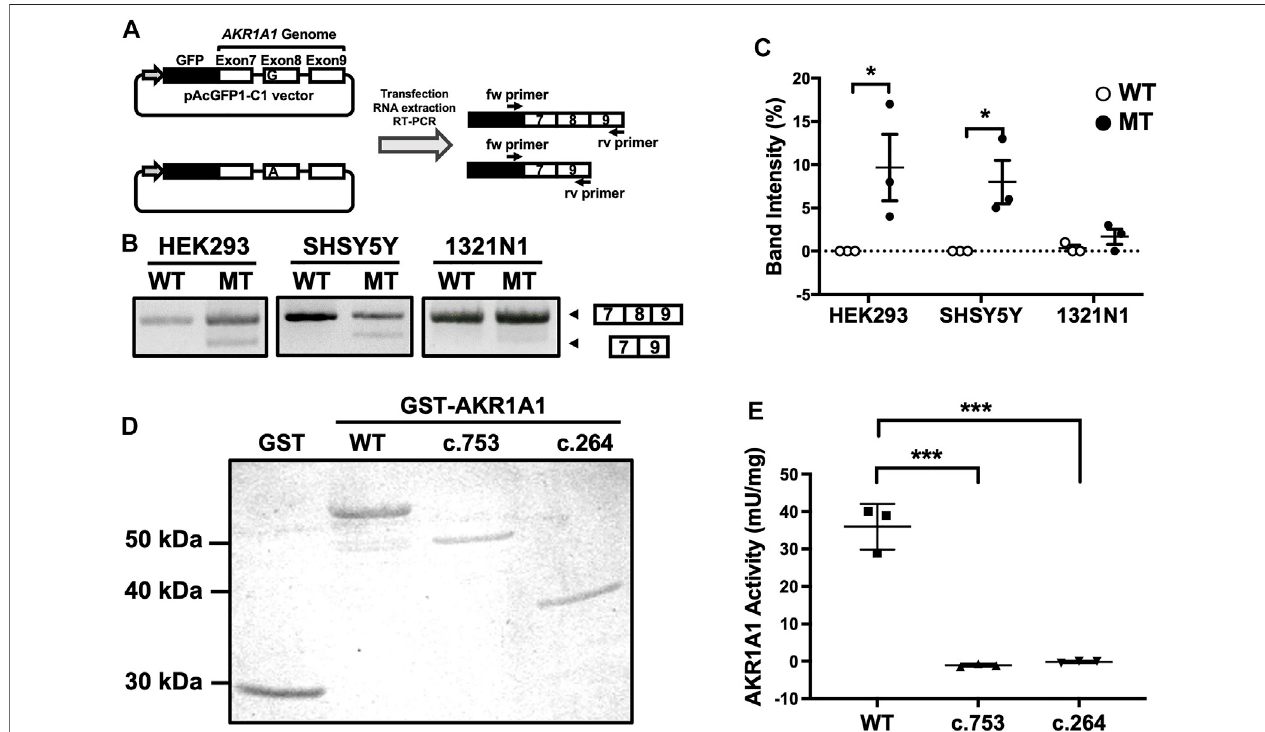
FIGURE2| Exonskippinginducedbythec.753G > Avariantin AKR1A1 . (A) Anoutlineofthesplicingassayisshown.Exon8skippingwascon fi rmedusingcDNA generatedfromHEK293,SH-SY5Y,and1321N1 cellsexpressingminigenesforWTorc.753G > Avariant(mutant[MT]). (B) Theresultsofthesplicingassayareshown. The upperband indicates products including exons7 – 9,whereas thelowerbandshows exon8skipping products, including only exons7and9. (C) Datarepresentthe meanofthreeindependentexperimentsforthesplicingassay.Two-wayanalysisofvariance: